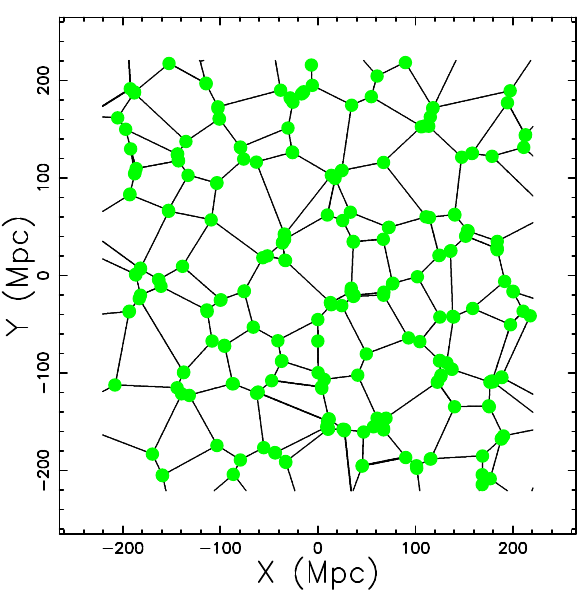
Figure 4. Portion of the Poissonian Voronoi diagram V P (2, 3); cut on the X-Y plane, black points, the parameters are given in Table 2. The spherical nodes are marked by great green points.